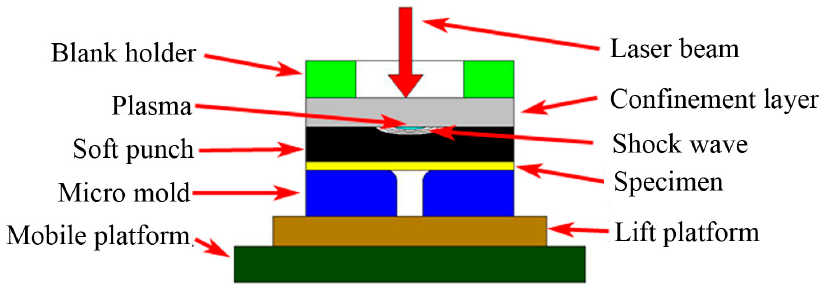
Figure 2. Experiment appliance of microscale laser flexible forming.